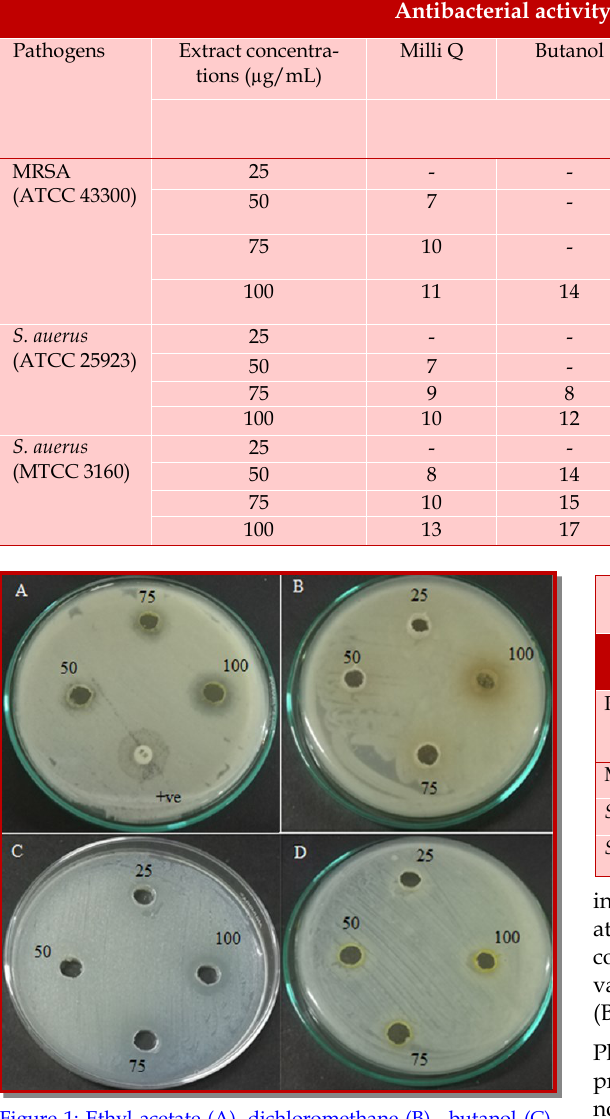
Figure 1: Ethyl acetate (A), dichloromethane (B), butanol (C), and water (D) crude extracts against